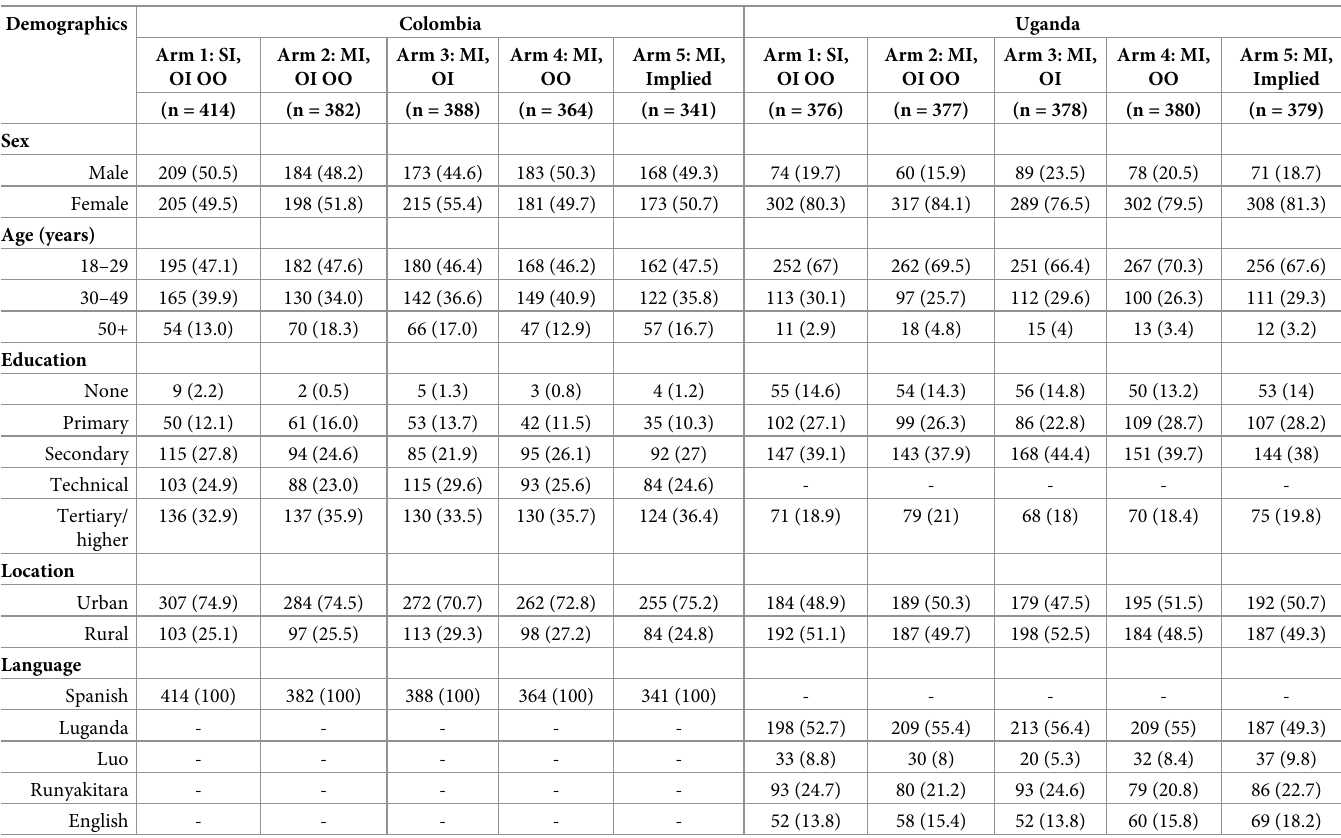
Table 1. Demographics of complete interviews by study arm in Colombia and Uganda, n